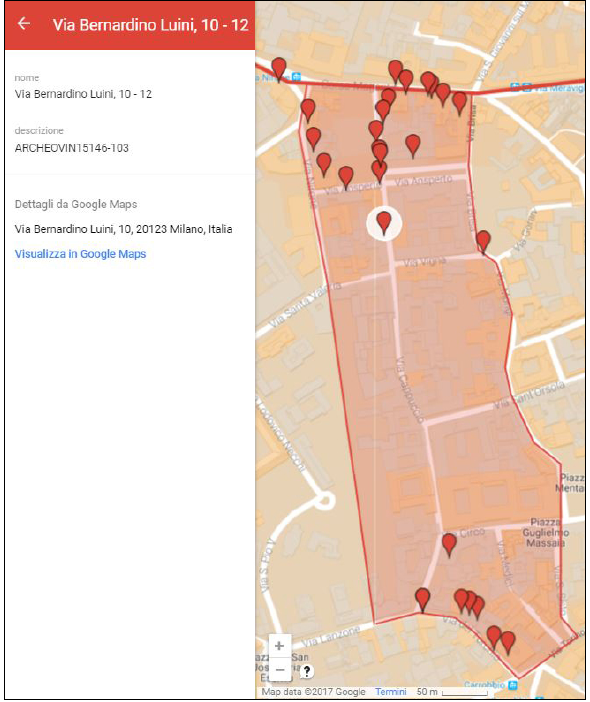
Figure 6. Mapping of areas subject to archaeological restrictions decrees (red points on the